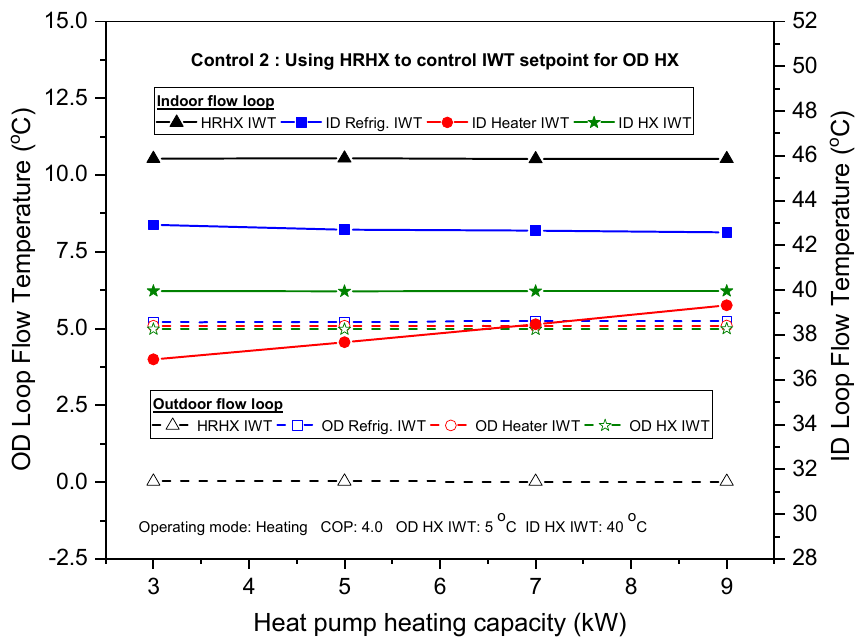
Figure 5. Flow loop temperature with variation in heat pump heating capacity for control (2).